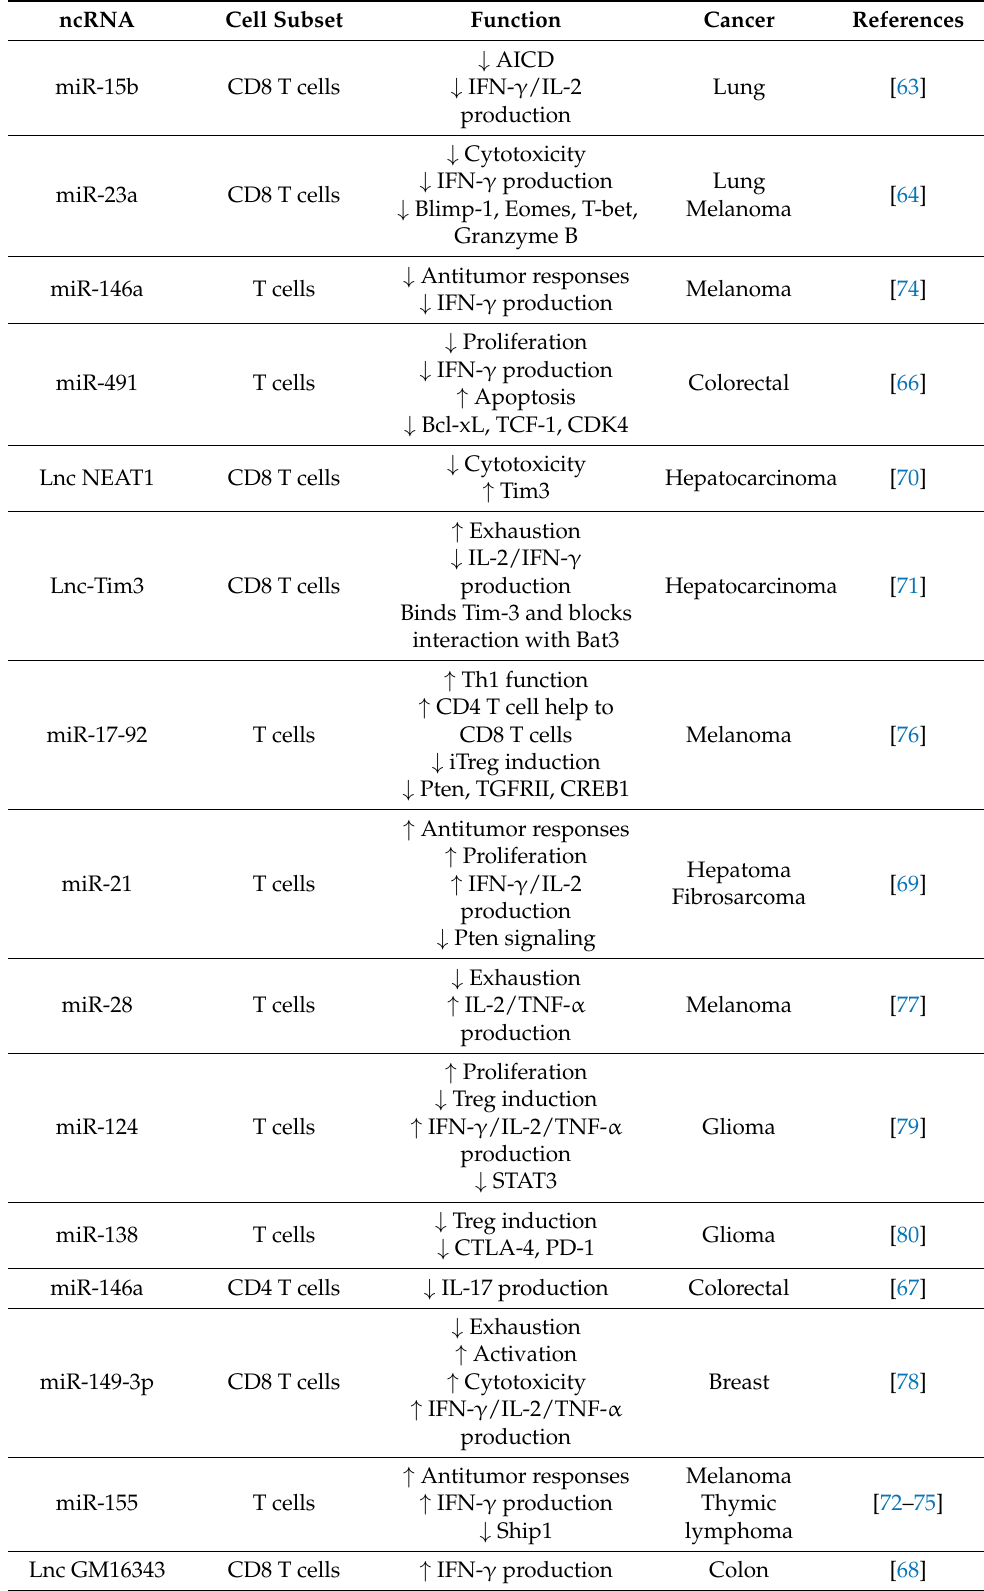
Table 1. Overview of ncRNA functions in the context of tumor